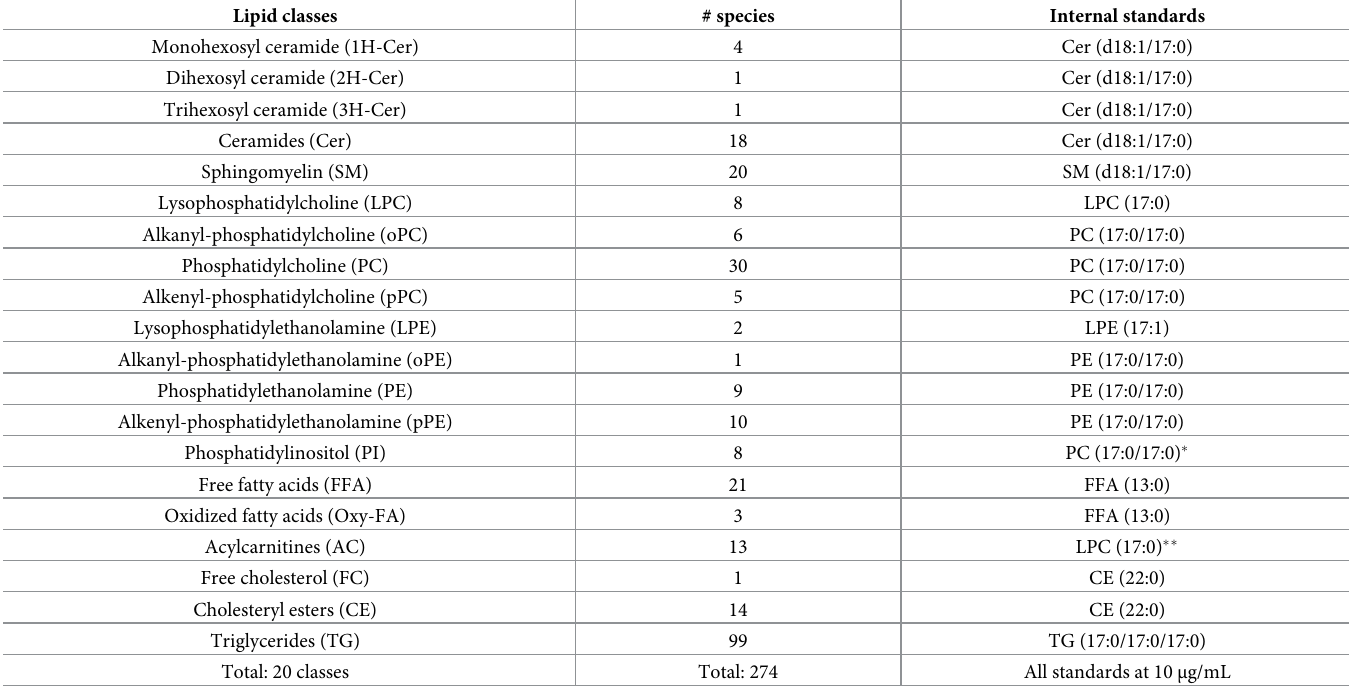
Table 1. Lipid classes, number of lipid species and internal standards used for semi-quantification by untargeted lipidomics. Lipid classes # species Internal